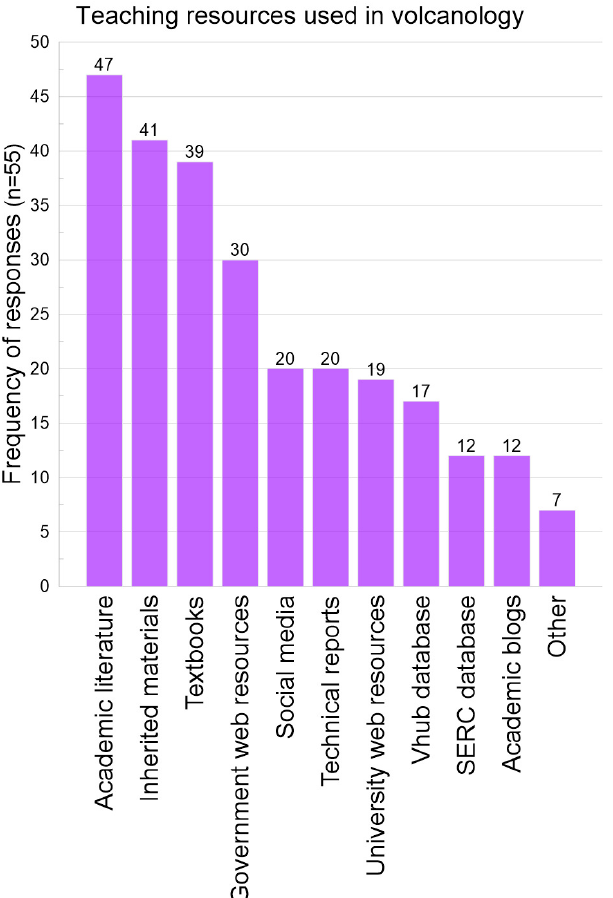
Figure 4: Activities engaged in to support respondents’ learning and teaching. The primary y-axis shows the fre- quency of respondents that said they engaged in each particular activity (instructors could select multiple op- tions). The secondary y-axis shows the mean value re- spondents placed on each activity, on a scale of 1 being very low value and 7 being very high